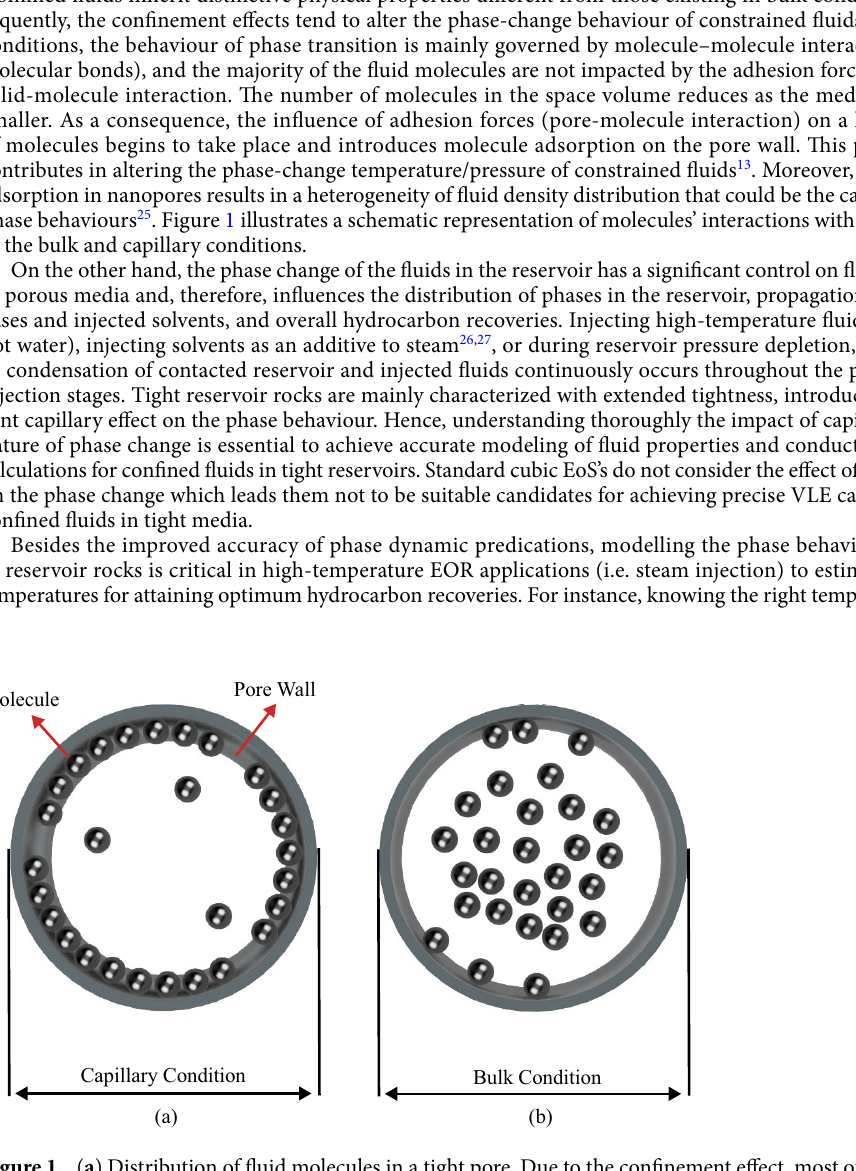
Figure 1. ( a ) Distribution of fluid molecules in a tight pore. Due to the confinement effect, most of the molecules are adsorbed by the inner pore surface; ( b ) distribution of fluid molecules in a bulk medium with no capillary effect. The minority of the molecules are adsorbed by the solid surface since the cohesion forces (intermolecular forces) are the